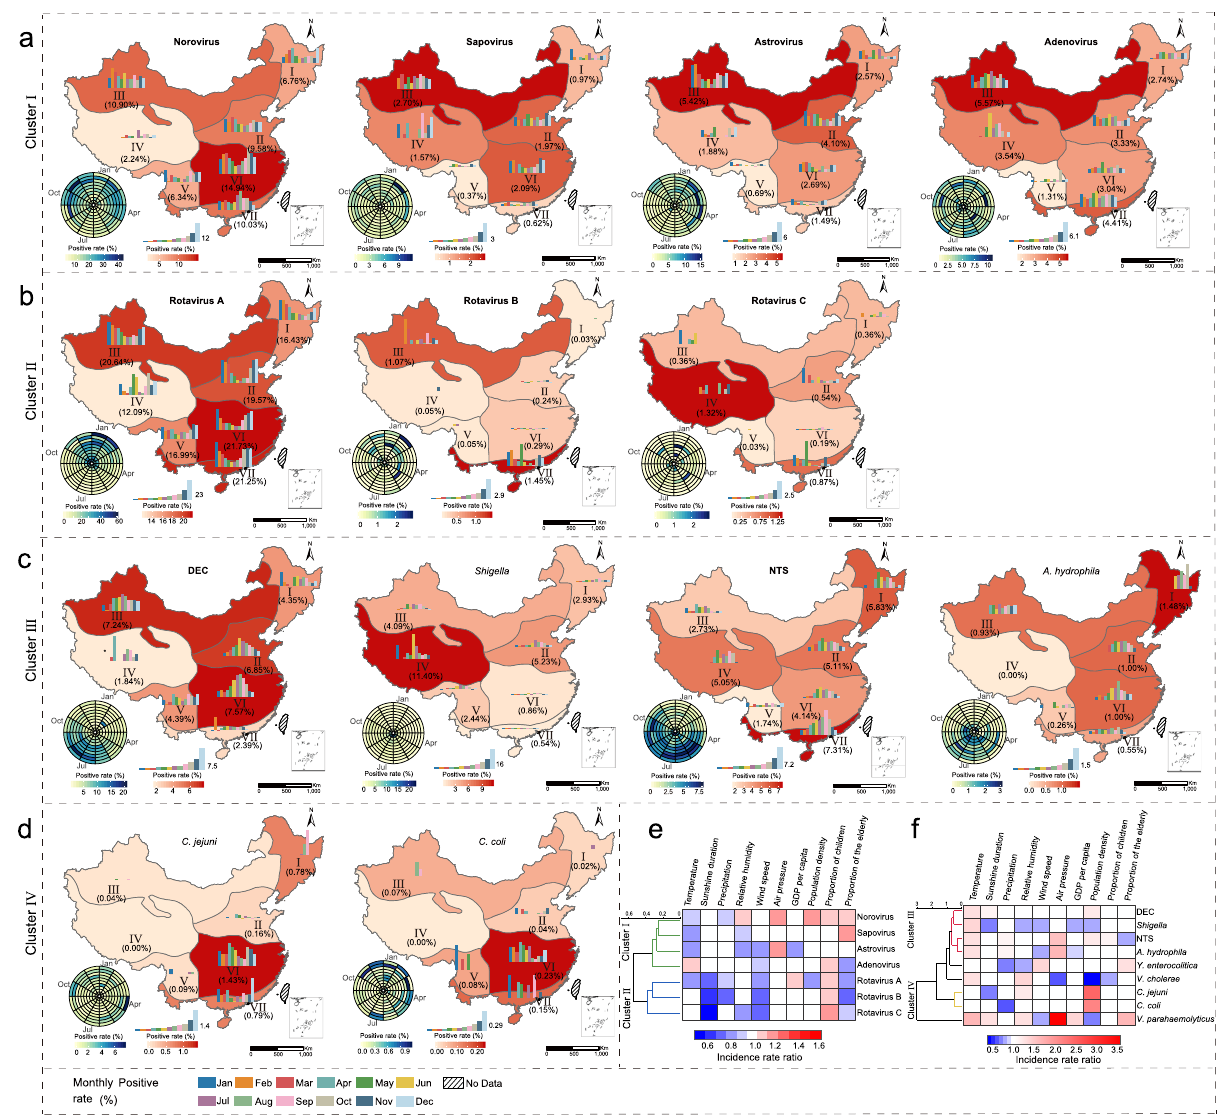
Fig. 5 Spatial and temporal pattern of four clusters of enteropathogens in patients with diarrhea in the mainland of China during 2009 ‒ 2018. Thirteen of the tested enteropathogens were formed into four clusters ( a ‒ d ). The seasonality was presented with a radar diagram based on the monthly positive rate from 2009 to 2018. The circumference is divided into 12 months in a clockwise direction, and the radius from inside to outside represents a particular year from 2009 to 2018. Seven ecological regions were marked (I, Northeast China district; II, North China district; III, Inner Mongolia-Xinjiang district; IV, Qinghai-Tibet district; V, Southwest China district; VI, Central China district; VII, South China district). Within each ecological region, the positive rate was noted and re fl ected by the background color. Histograms within each ecological region indicate the monthly positive rate averaged from 10-year data. The height of the bars indicates the positive rate of each month. *No sample in the month. The dendrogram in e , f display the clusters I ‒ IV. Green lines mean cluster I. Blue lines mean cluster II. Red lines mean cluster III. Yellow lines mean cluster IV. The incidence rate ratio, ranging from negative in fl uence (blue) to positive in fl uence (red). The features used for clustering are variables with statistically signi fi cant differences in the negative binomial model. DEC diarrheagenic Escherichia coli ; NTS nontyphoidal Salmonella . Source data are provided as a Source Data fi